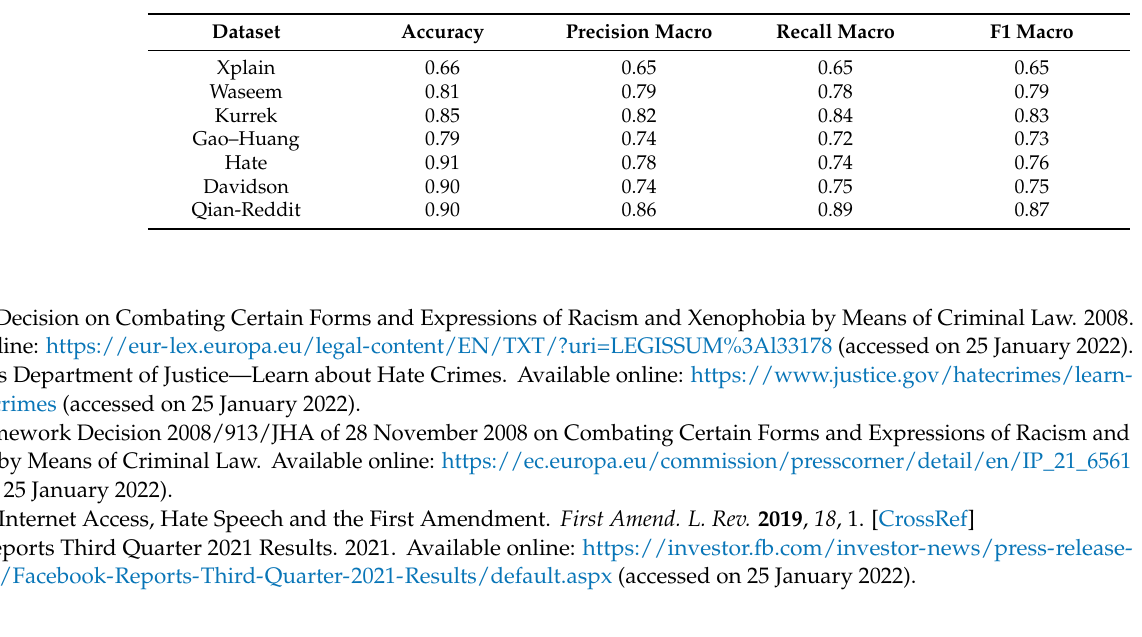
Table A13. Scores obtained on the benchmark Datasets using 2 LSTM layers and embedding the words with both ELMo and GloVe